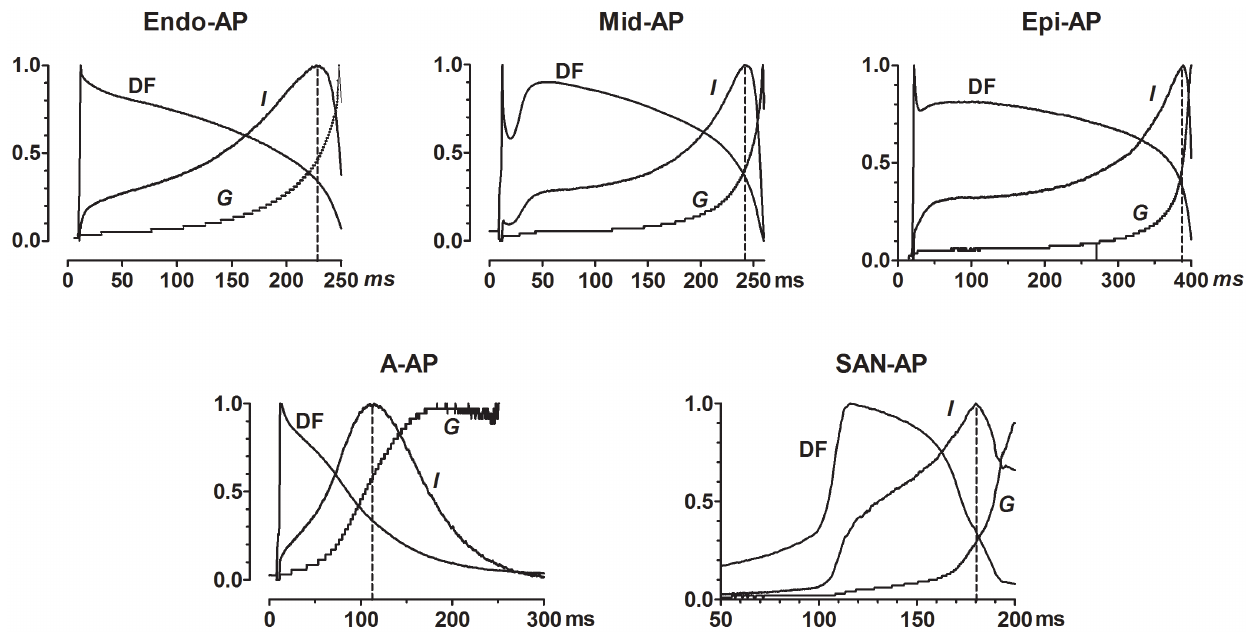
Figure 6. Direct comparisons of normalized current ( I ), conductance ( G ) and driving force (DF). G and DF were calculated using the equations: G = I / V and DF= I / G , respectively, where V represents the dynamic membrane potential during an AP. All data points were normalized by dividing by the maximum values. The vertical dash lines define the time at which I HERG peaks. Note that while I begins to decline, G continues to rise, after the peak.